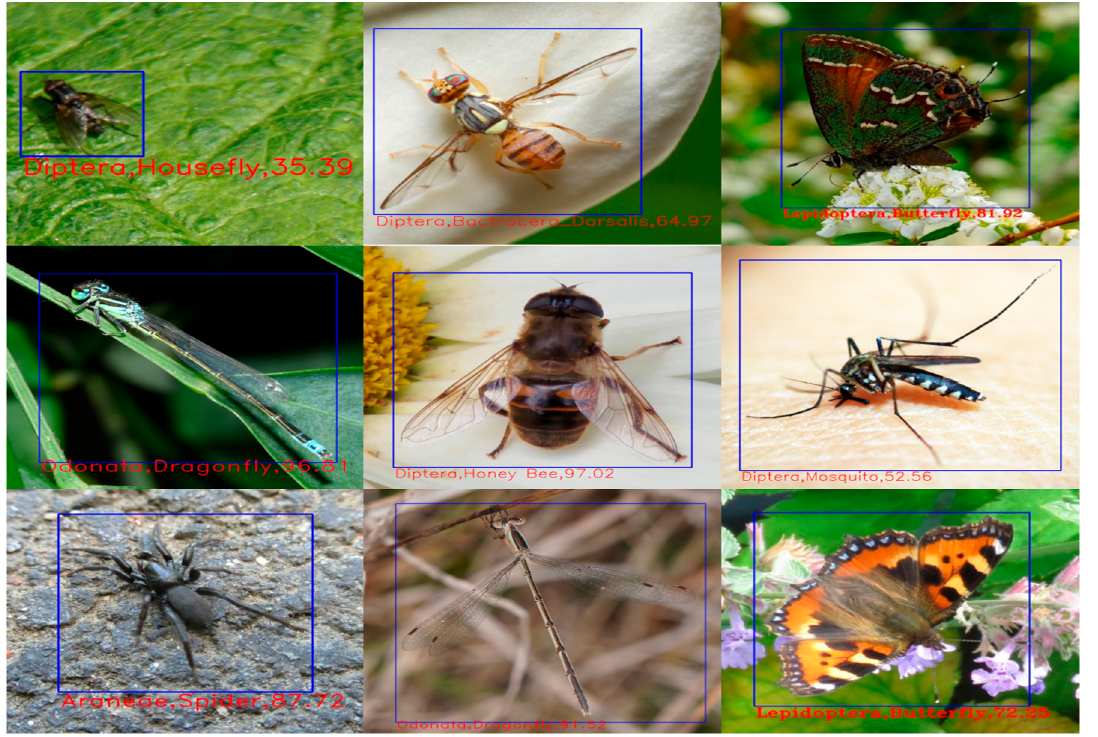
Figure 8. Detection results of YOLOv5x on di ff erent insect species.